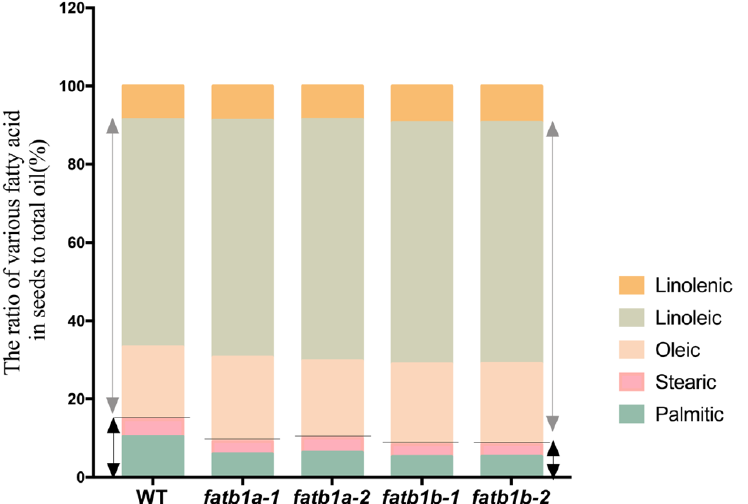
Figure 4. The ratio of the fatty acids in seeds to total oil. The proportions of various fatty acids are shown in the figure. The five colors in the picture represent different types of fatty acids. Below the solid gray lines represent saturated fatty acids, and above the solid gray lines represent unsaturated fatty acids. The black double arrows represent saturated fatty acids, and the gray double arrows represent unsaturated fatty acids. WT, wild type.